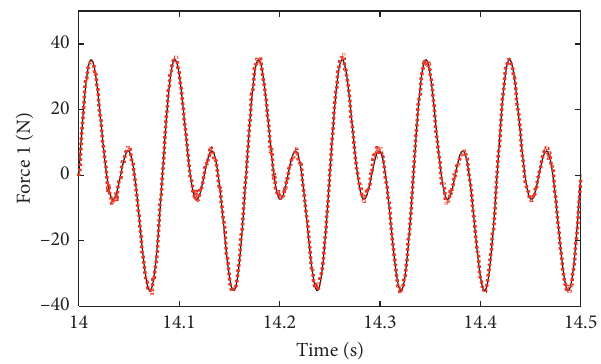
Figure 6: Amplification of the clip (14–14.5s) of Figure 5.